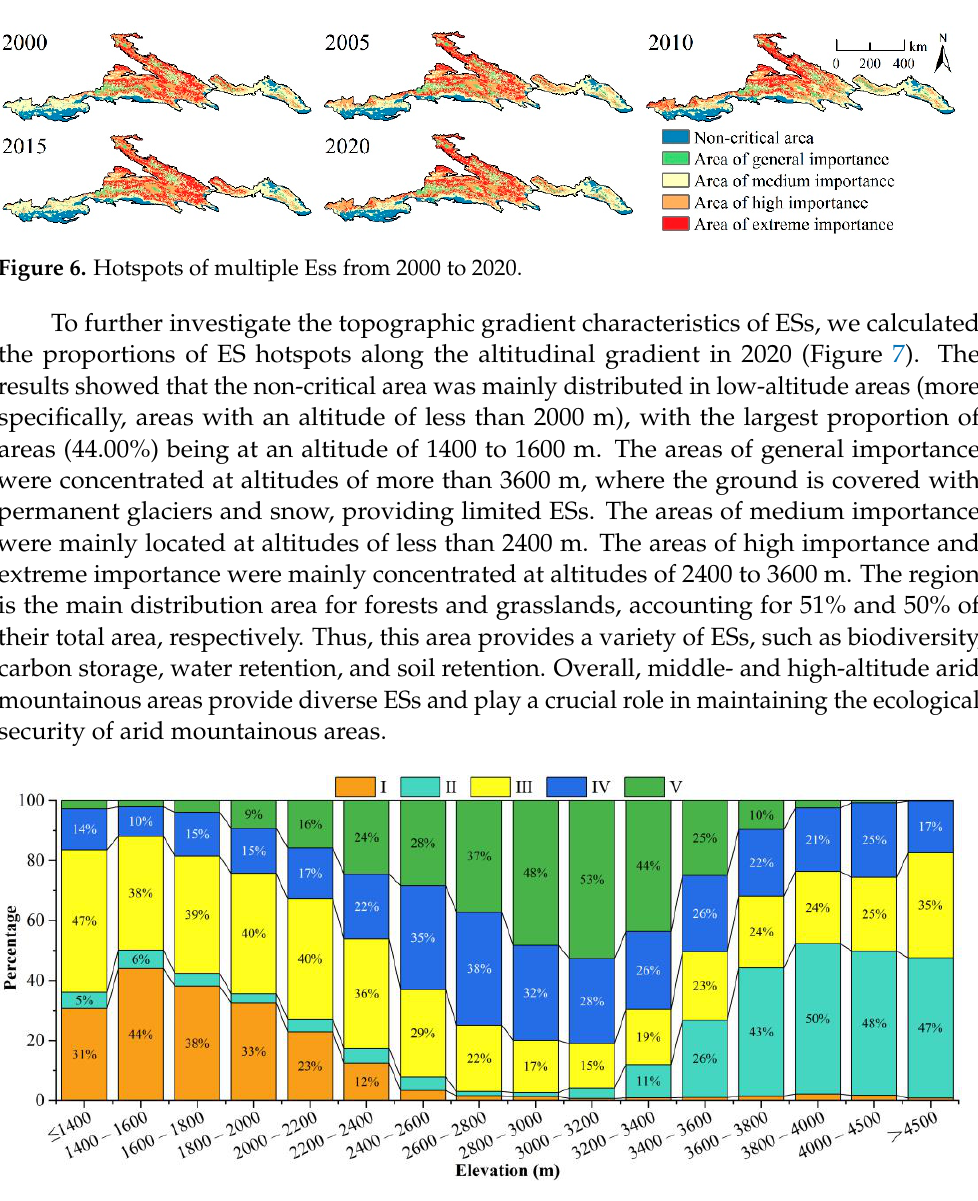
Figure 7. Distribution of ES hotspots at different elevations. Note: I is the non-critical area, II is the area of general importance, III is the area of medium importance, IV is the area of high importance, and V is the area of extreme